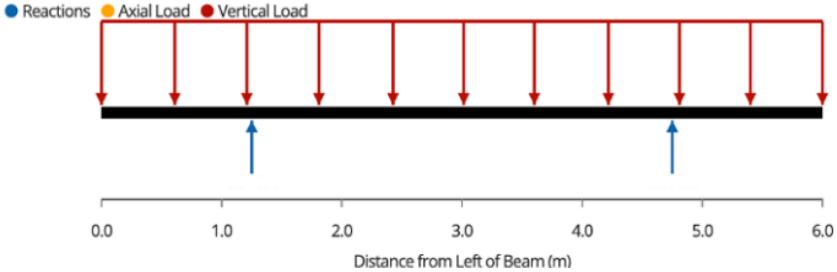
Figure A1. Single-span joist free-body diagram.